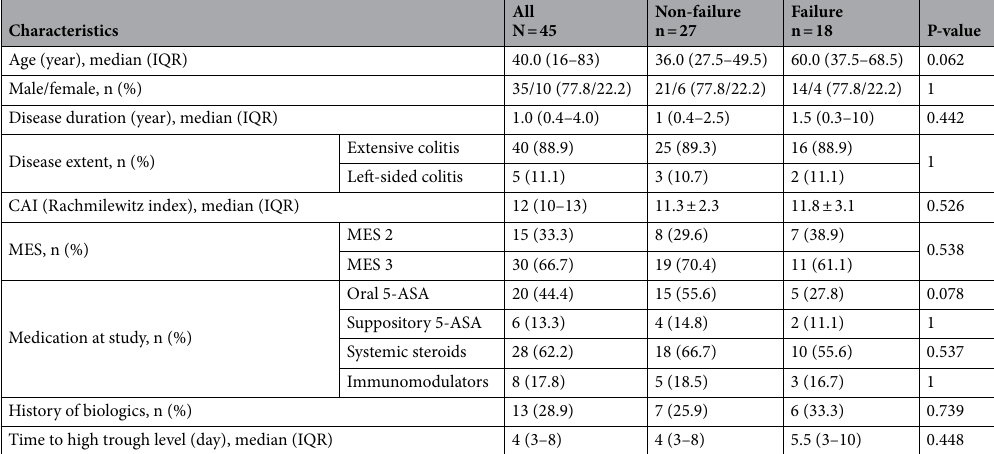
Table 1. Baseline characteristics of patients. IQR, interquartile range; CAI, clinical activity index; MES, Mayo endoscopic subscore; 5-ASA, 5-aminosalicylic acid.